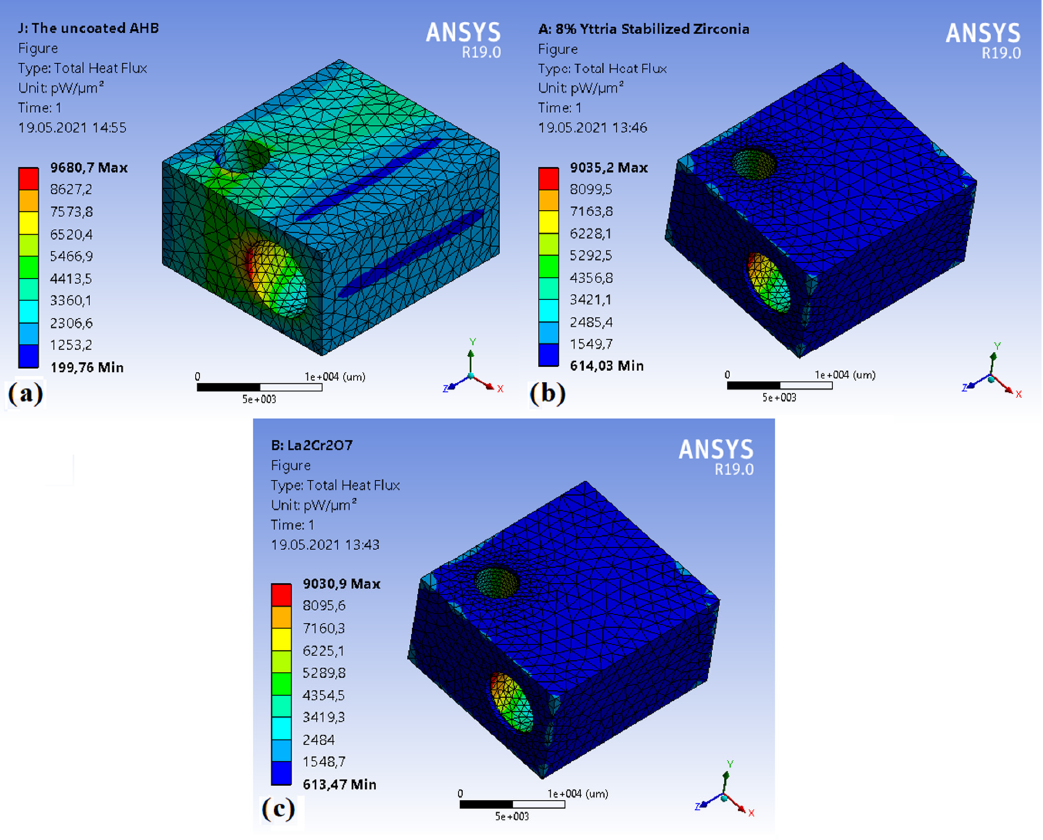
Figure 11. Heat flux density of ( a ) uncoated, ( b ) YSZ-coated, and ( c ) La 2 Cr 2 O 7 -coated AHB.